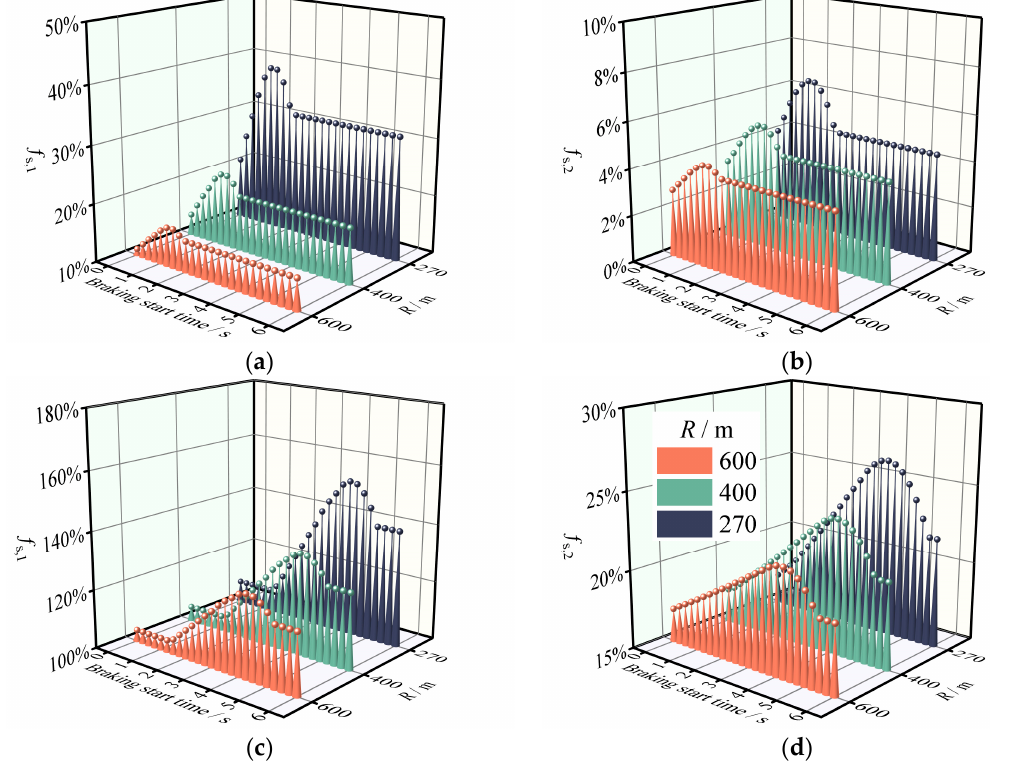
Figure 11. The SUV’s safety margin reduction rate on horizontal curves and grade combinations when braking and lane changing are combined (LCD = 6 s). ( a ) Sideslip margin reduction rate for LC_A with braking maneuver. ( b ) Rollover margin reduction rate for LC_A with braking maneuver. ( c ) Sideslip margin reduction rate for LC_B with braking maneuver. ( d ) Rollover margin reduction rate for LC_B with braking maneuver.